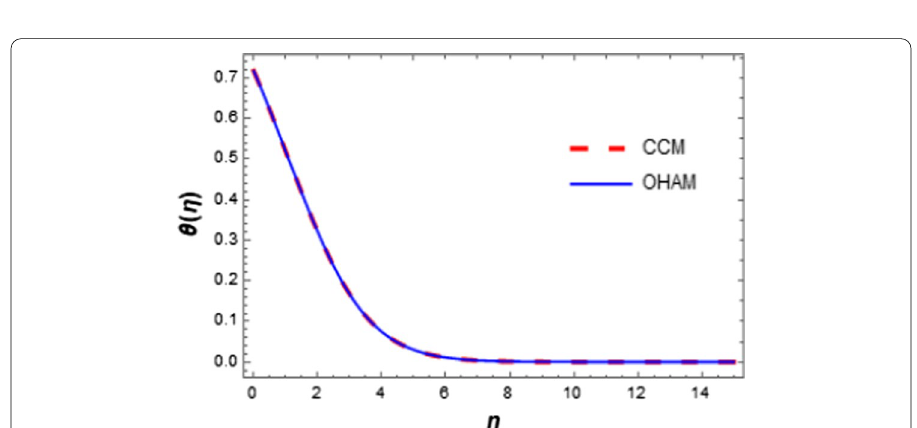
Fig. 4 Comparison of the temperature profile obtained using and CCM and